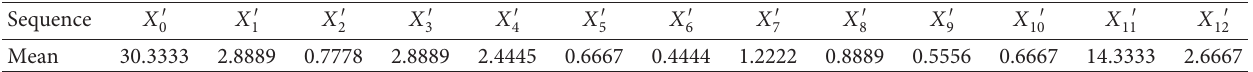
Table 2: Miners’ unsafe behavior for each sequence